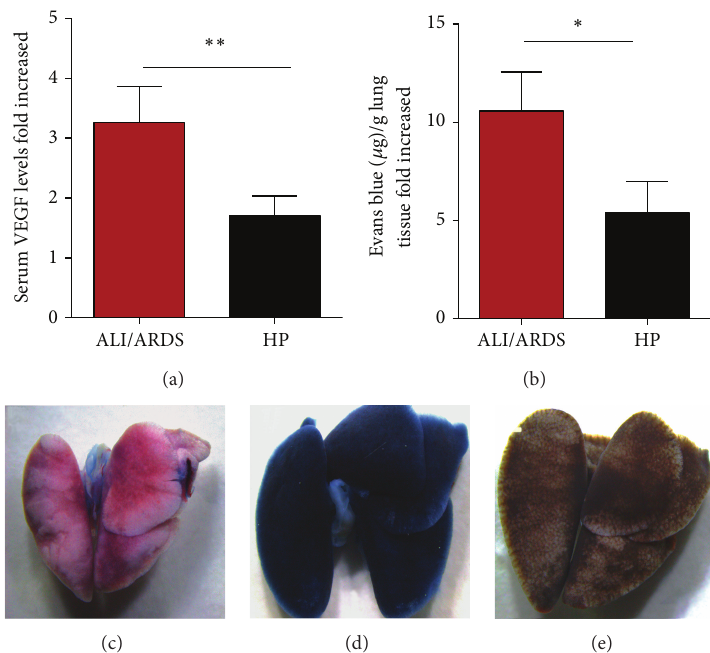
Figure 6: Increased vascular permeability and serum VEGF protein confirmed the predictive criteria for malaria-associated ALI/ARDS. (a) Serum VEGF protein in DBA/2 mice infected with P. berghei ANKA on the 7th DAI was measured by ELISA. The VEGF levels are higher in the mice classified as likely to die with ALI/ARDS compared with HP mice (according to the proposed predictive criteria). The data represent fold increases in relation to NI mice taken from three experiments; ( 𝑛 = 28 mice; ∗∗ 𝑃 < 0.005 , Mann-Whitney test). (b) Lung vascular permeability in DBA/2 mice infected with P. berghei ANKA 7th DAI, assessed using Evans Blue. The vascular permeability is higher in the mice classified as likely to die with ALI/ARDS compared with the HP mice (according to the proposed predictive criteria). The data represent fold increased in relation to NI mice taken from three experiments; ( 𝑛 = 51 mice; ∗ 𝑃 < 0.05 , Mann-Whitney test). Bars represent means and SEM. The images represent (c) NI: noninfected mice, (d) ALI/ARDS: acute lung injury acute respiratory distress syndrome, and (e) HP: